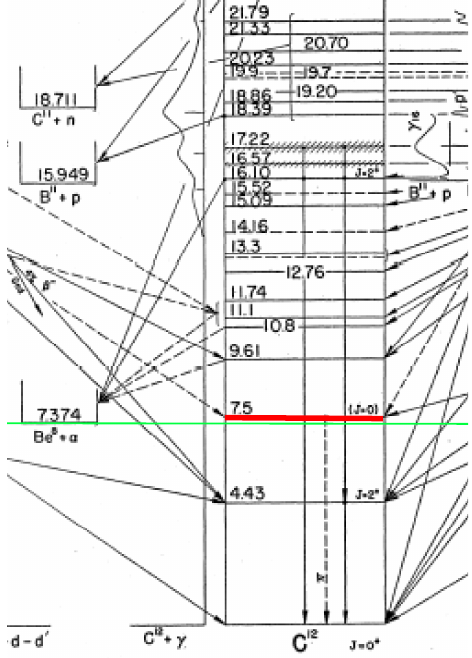
Figure 8.12: The structure of 12 C as was known in 1952. For the Figure 7: The structure of the 12 C nucleus as sum- marized in 1952. The energy level under discussion is marked in red and is at 7.5MeV. Note that the authors assigned the level J = 0 , which is identical with that of the ground state. But 0 0 transitions are →